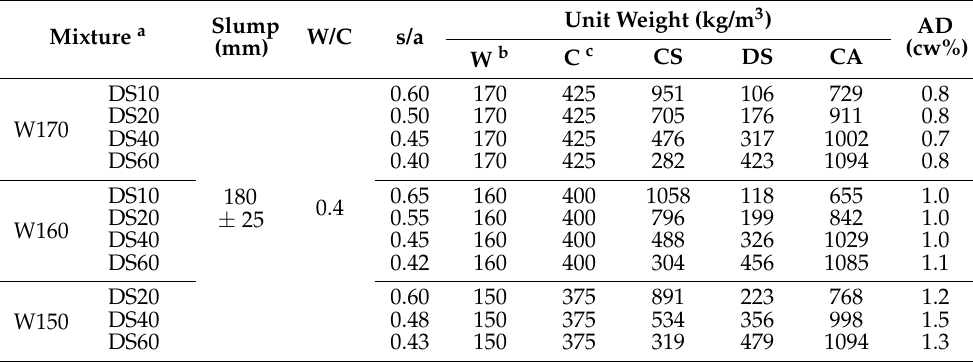
Table 3. Proportions for the different concrete mixtures used in this study. Mixture